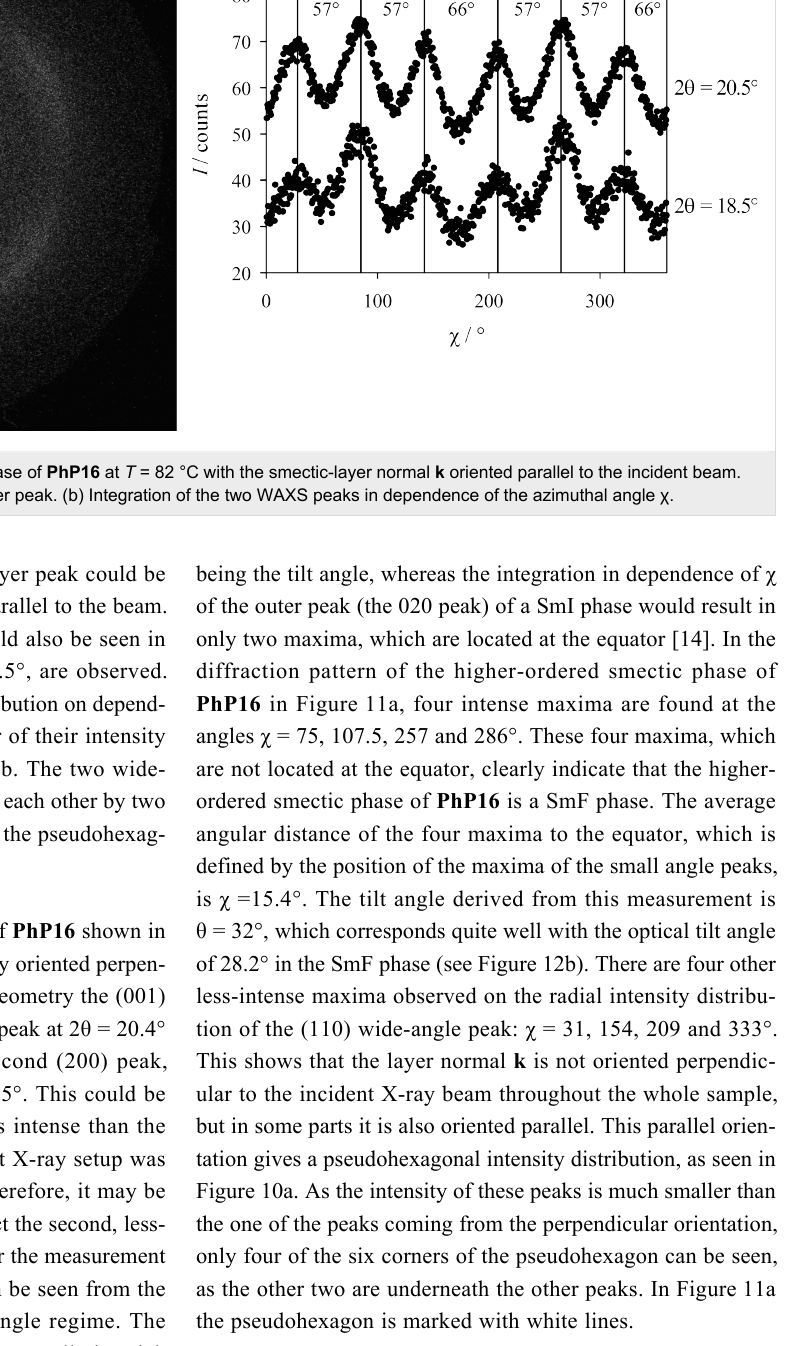
Figure 10: (a) WAXS-measurement of the SmF phase of PhP16 at T = 82 °C with the smectic-layer normal k oriented parallel to the incident beam. Two wide-angle peaks can be observed, but no layer peak. (b) Integration of the two WAXS peaks in dependence of the azimuthal angle χ .